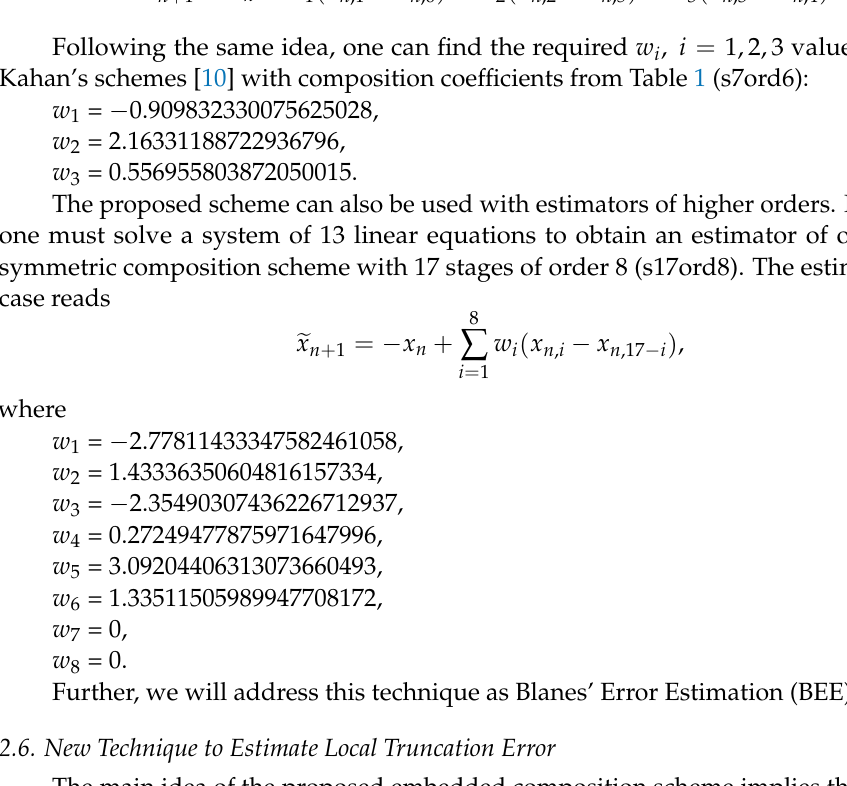
(𝑥 (𝑥 𝑛,𝑖 𝑛 ) , 𝐱 = ) ; 𝛷 𝑦 𝑦 𝑛,𝑖 1 is a semi-explicit D method; 𝑛,𝑖 𝑛